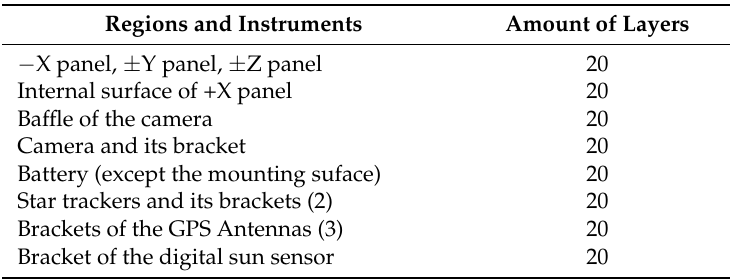
Table 8. Regions and instruments of Luojia 1-01 covered by MLI.